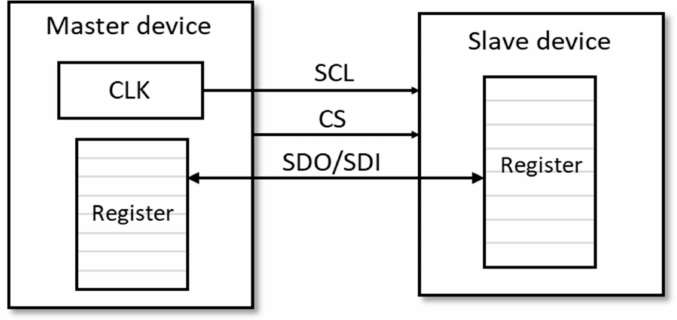
Figure 5. The 3-wire SPI protocol block